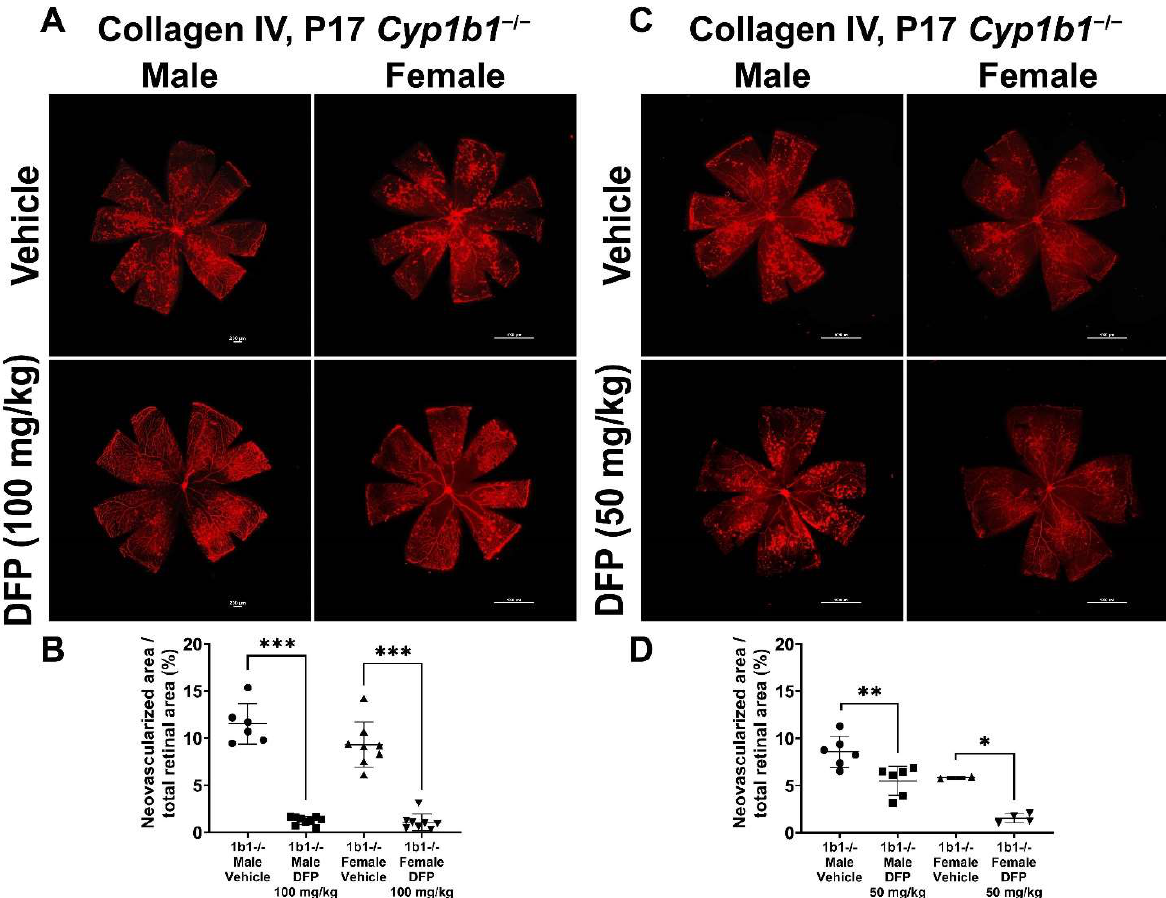
Figure 11. Effect of iron chelation by deferiprone (DFP) on retinal neovascularization in Cyp1b1 −/− mice during OIR. Cyp1b1 −/− mice were administrated with ( A ) 50 mg/kg or ( C ) 100 mg/kg of DFP (daily IP injection prepared in 50 µL saline, from P12 through P17) in separate OIR experiments. Retinas from those mice at P17 were wholemount stained with anti-collagen IV antibody and imaged by fluorescent microscopy. Scale bars = 1000 µm. Quantitative assessment of the neovascularization was performed using ImageJ and percentages of the neovascularized area in the mice are shown in ( B , D ) respectively (* p < 0.05, ** p < 0.01, *** p < 0.001, n ≥ 2; each point represents one